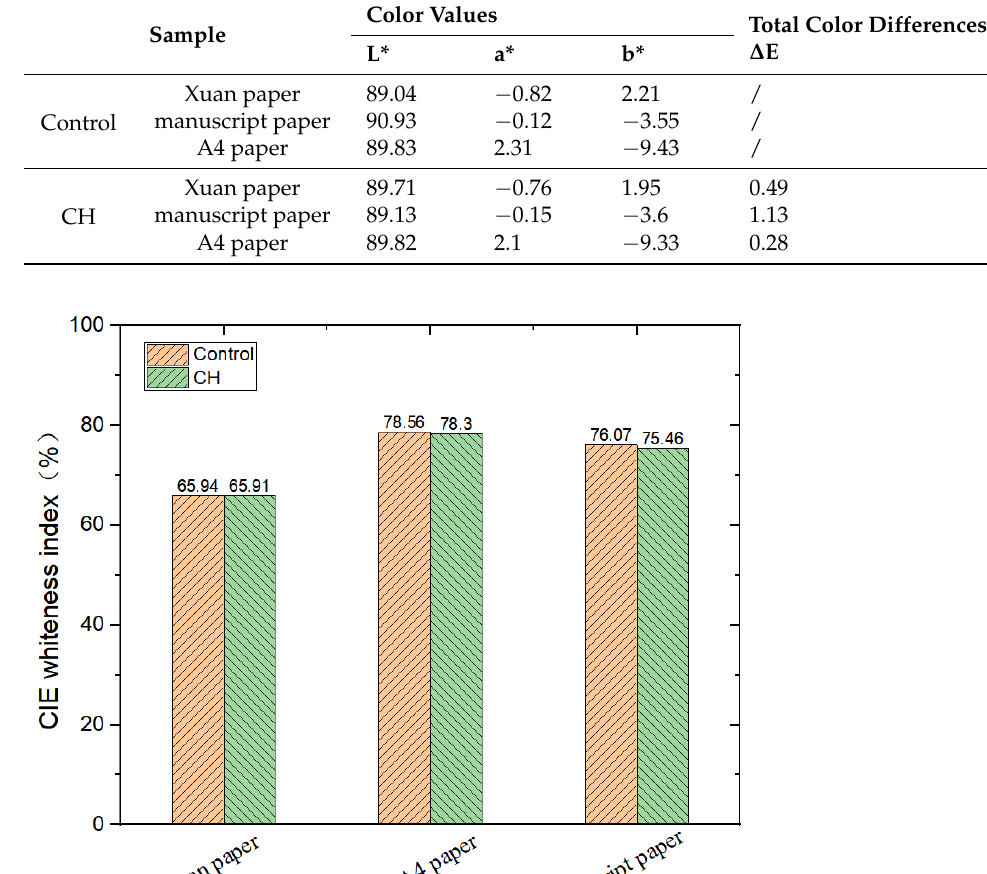
Table 3. Color measurement of paper treated with CH and untreated.